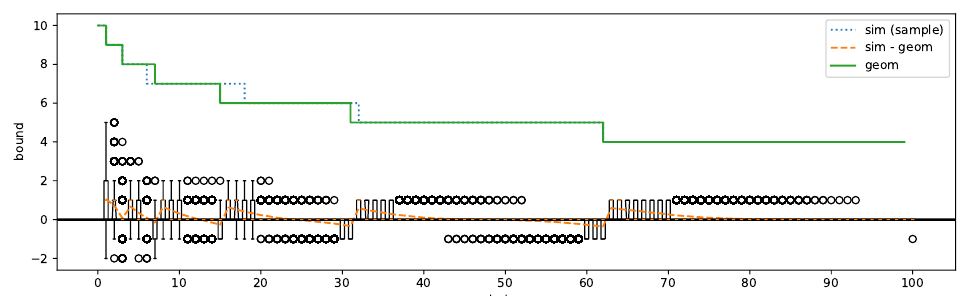
Figure 3: Plot of the geometric bounds ( geom ) with N = 2000 for d = 100 fastest signatures, along with a random sample of the true leading zero bits from simulated data ( sim ) and boxplots of the distribution of the difference of the simulated data and the bounds ( sim - geom ). Negative values imply an error; positive implies some available information is